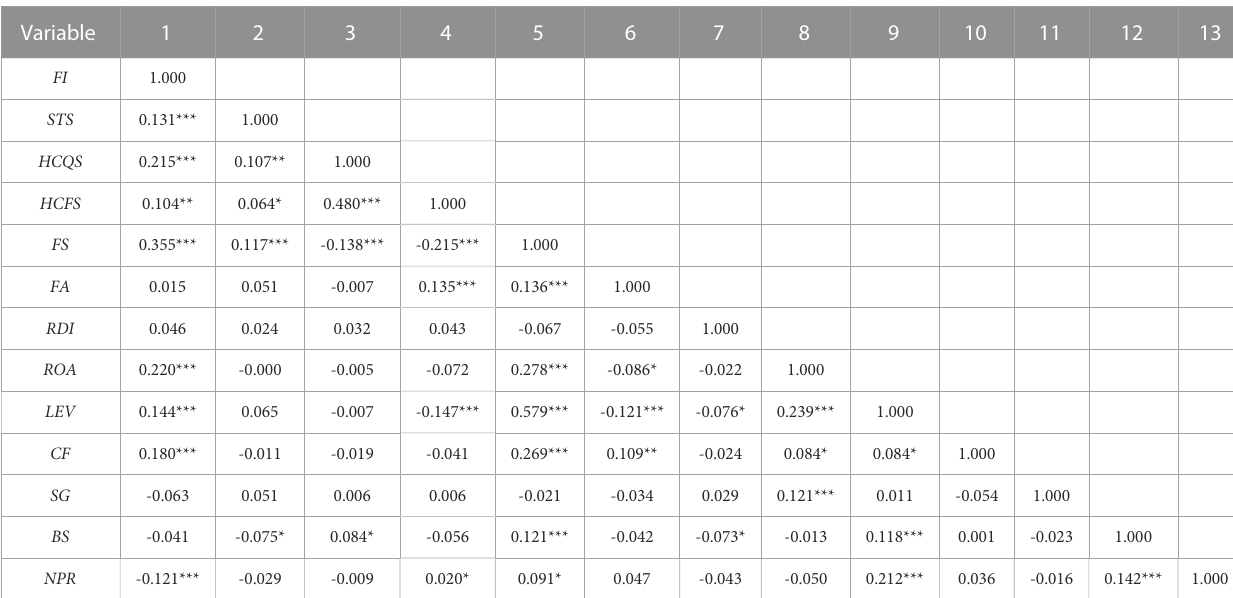
TABLE 4 Correlation